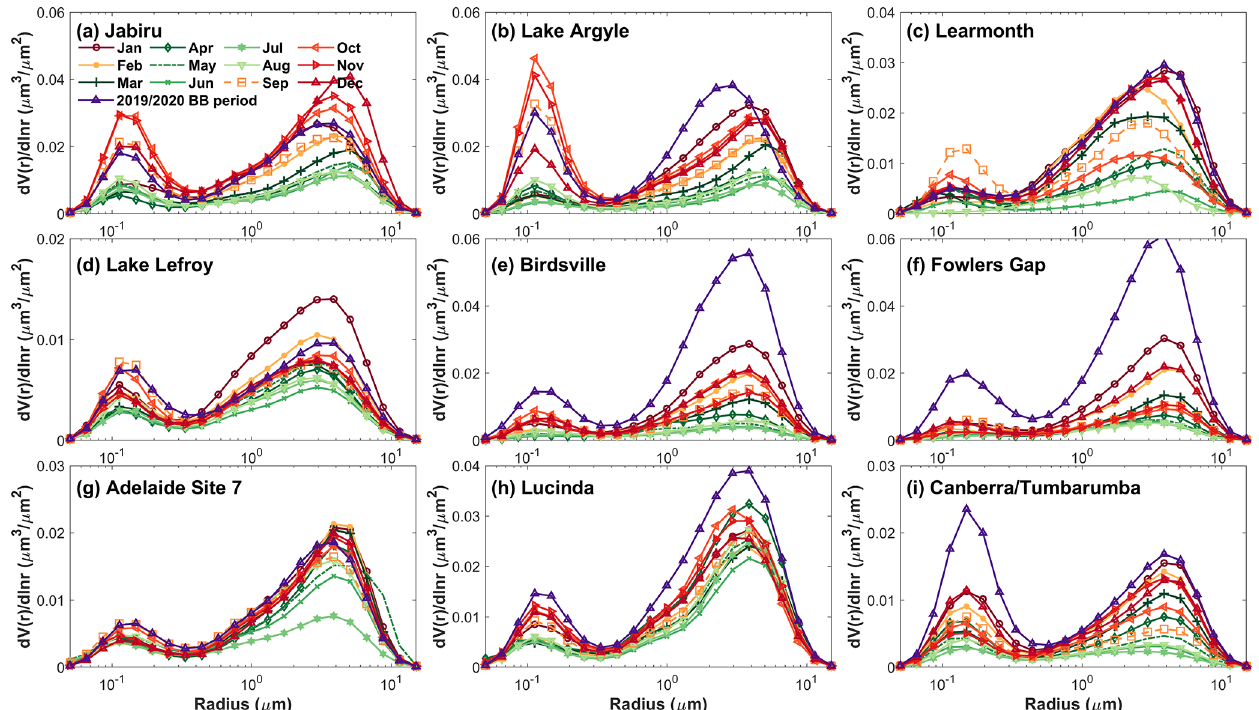
Figure 5. Monthly averaged aerosol volume size distributions at the nine AERONET sites over Australia. The warm-toned and cold-toned lines represent the aerosol size distributions in the BB period and the non-BB period, respectively. The purple line represents the aerosol size distribution in the BB period of